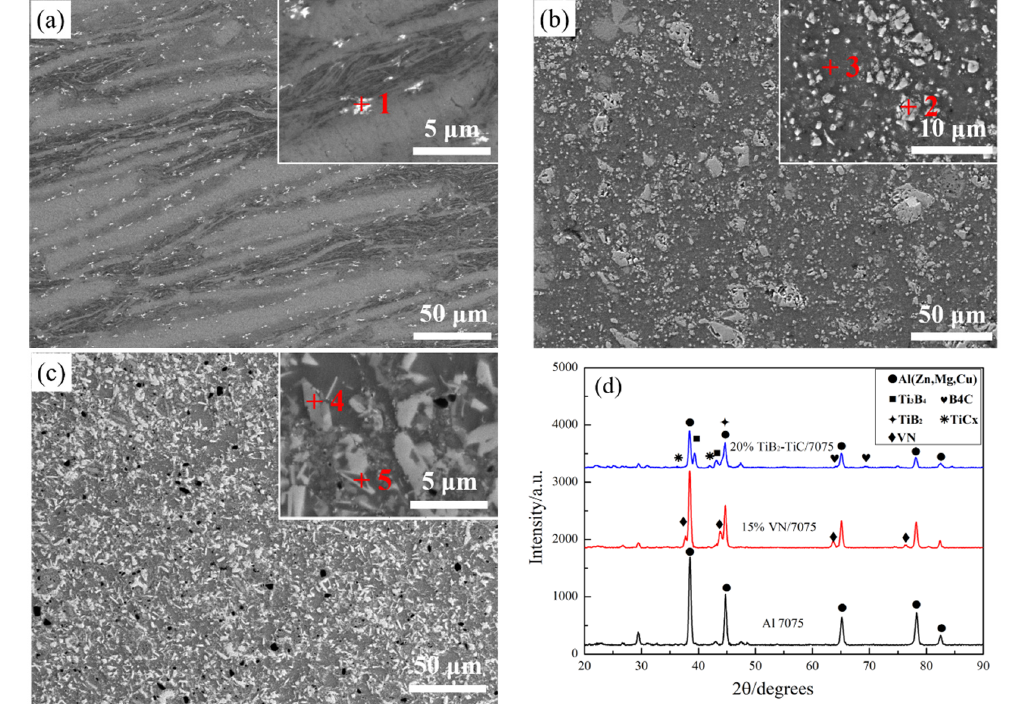
Figure 1. Microstructure and phase analysis of samples. ( a ) Al 7075; ( b ) 15 wt.% VN/7075; ( c ) 20 wt.% TiB 2 -TiC x /7075; ( d ) XRD pattern.